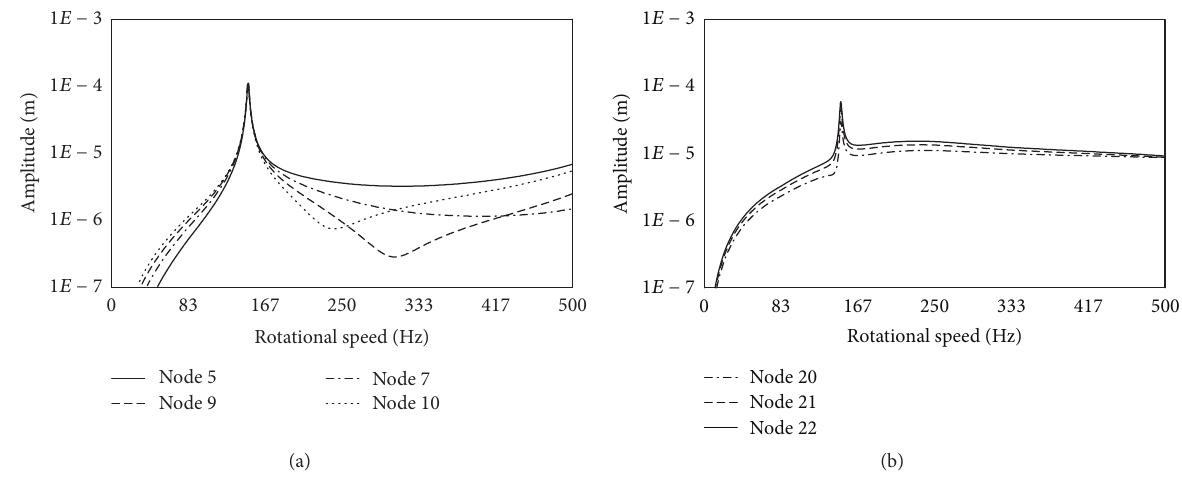
Figure 8: Unbalanced responses of the rotor-bearing system for the radial clearance of the squeeze film damper equal to 0.08 mm.